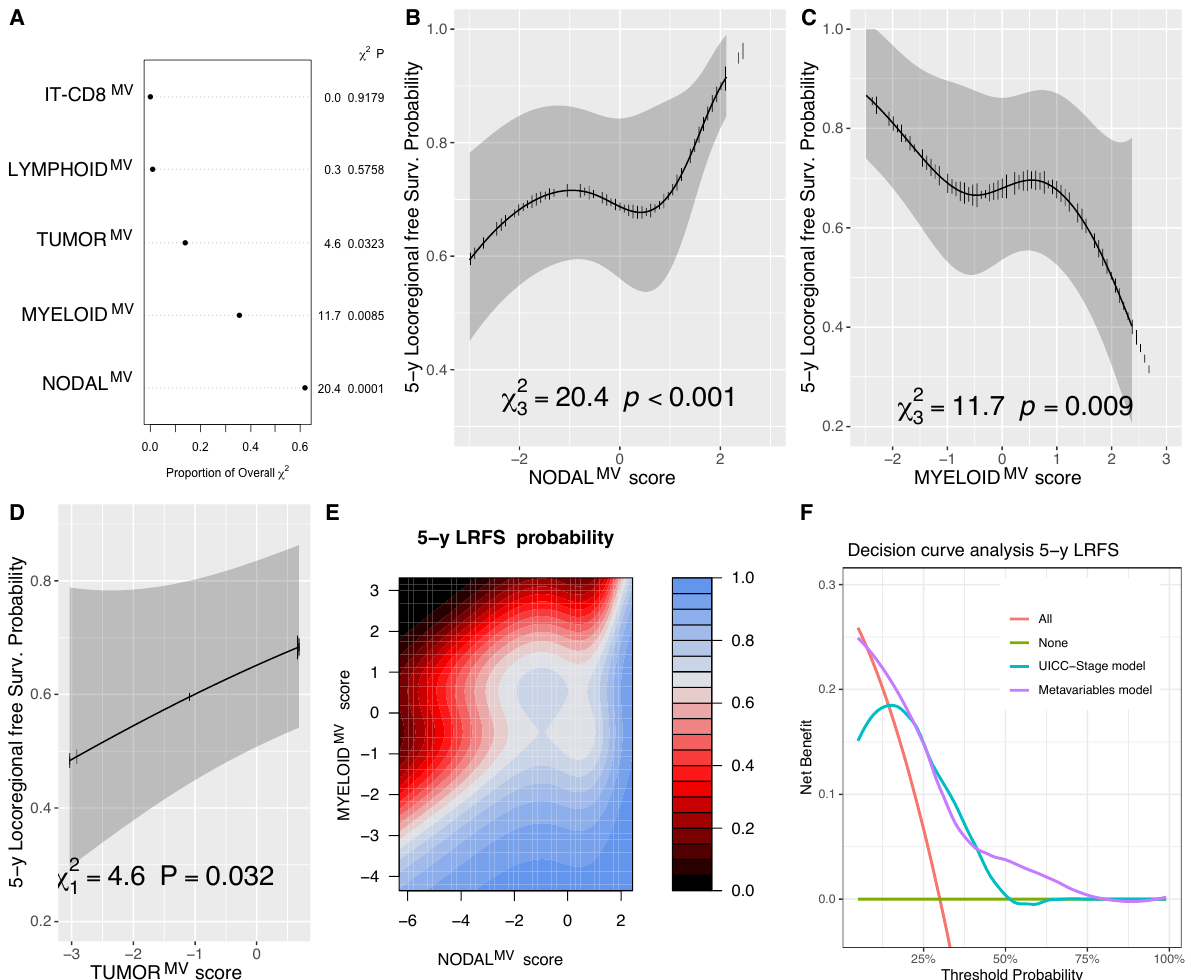
Figure 5. Chunk test results on the LRFS multivariable model reporting the proportion of the overall χ 2 of the model explained by each variable, the partial χ 2 and P value of the Wald test, testing the association between each variable and the outcome ( A ); adjusted marginal effect plots for the 5-year LRFS with CI 95% (gray bands) of the NODAL MV ( B ); MYELOID MV ( C ), and TUMOR MV ( D ) scores; contour plot showing isoprognostic LRFS bands according to the combined effect of the NODAL MV and MYELOID MV scores for the 5-year LRFS estimate—the color scale representing the 5 y LRFS probability ( E ); and decision curve analysis (DCA) showing a better performance of the model including MVs compared to the one fitted with the UICC overall stage alone in predicting the 5-year LRFS in the lowest and highest ranges of the estimated risks ( F